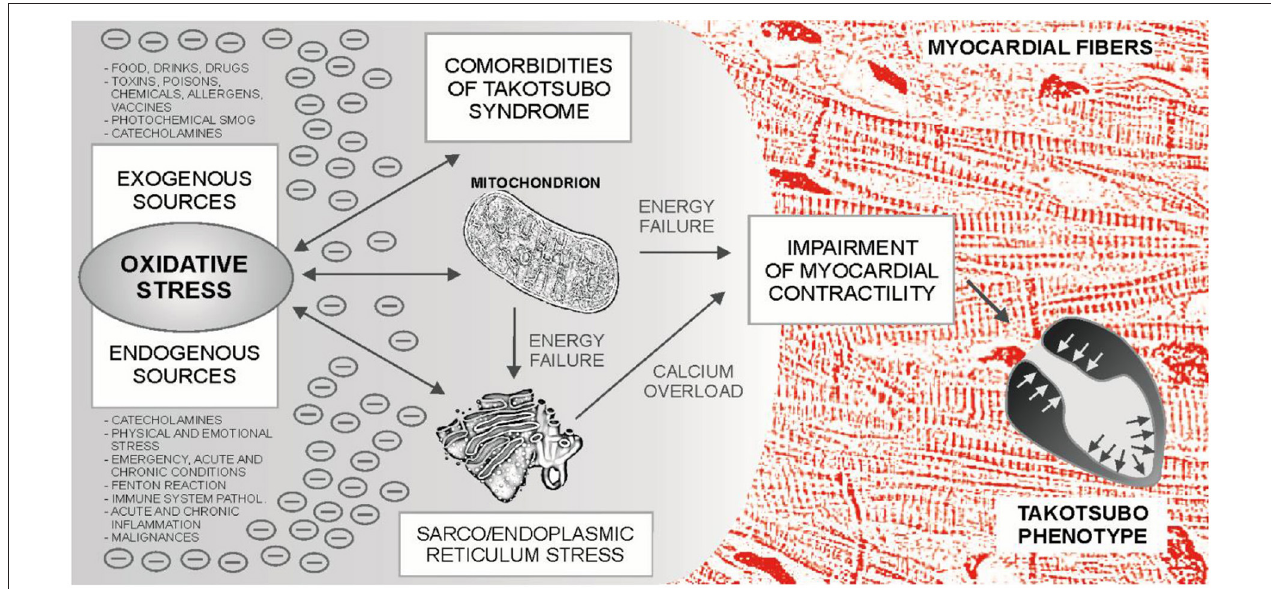
FIGURE 1 | Sources and effects of oxidative stress (OS) in Takotsubo syndrome (TTS). Prior to the development of an acute attack of TTS, various sources of OS can be identified, which can be combined with each other. The main sources of oxidative stress in the body are mitochondria and the mitochondria - sarco/endoplasmic reticulum complex, which are involved in xenobiotic metabolism, calcium turnover and myocardial contractility, among others. Catecholamines can act as metabolic accelerators in this system. Finally, accumulated oxidative stress could lead to the blockade of energy production, disruption of calcium turnover in the cardiomyocyte, impaired contractility, and to the development of the Takotsubo phenotype.